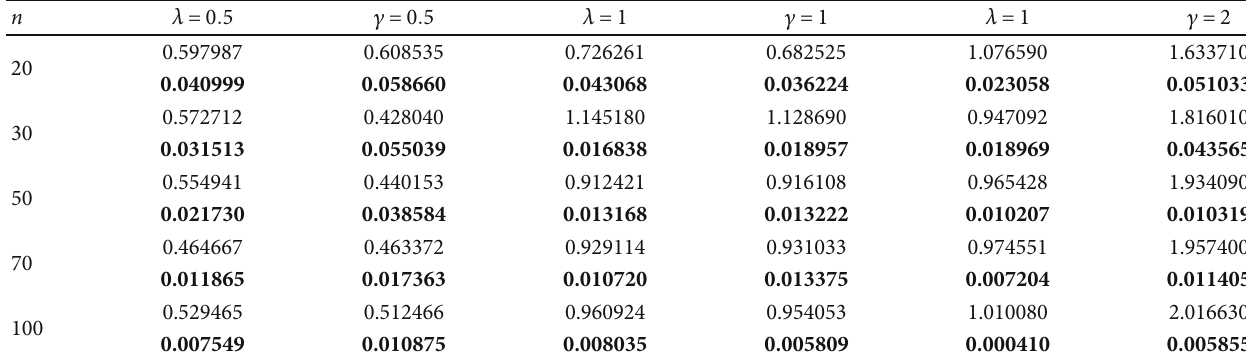
Table 9: BEs and PEs under ELF and informative prior λ = 0 : 5, 1 and γ = 0 : 5, 1, 2